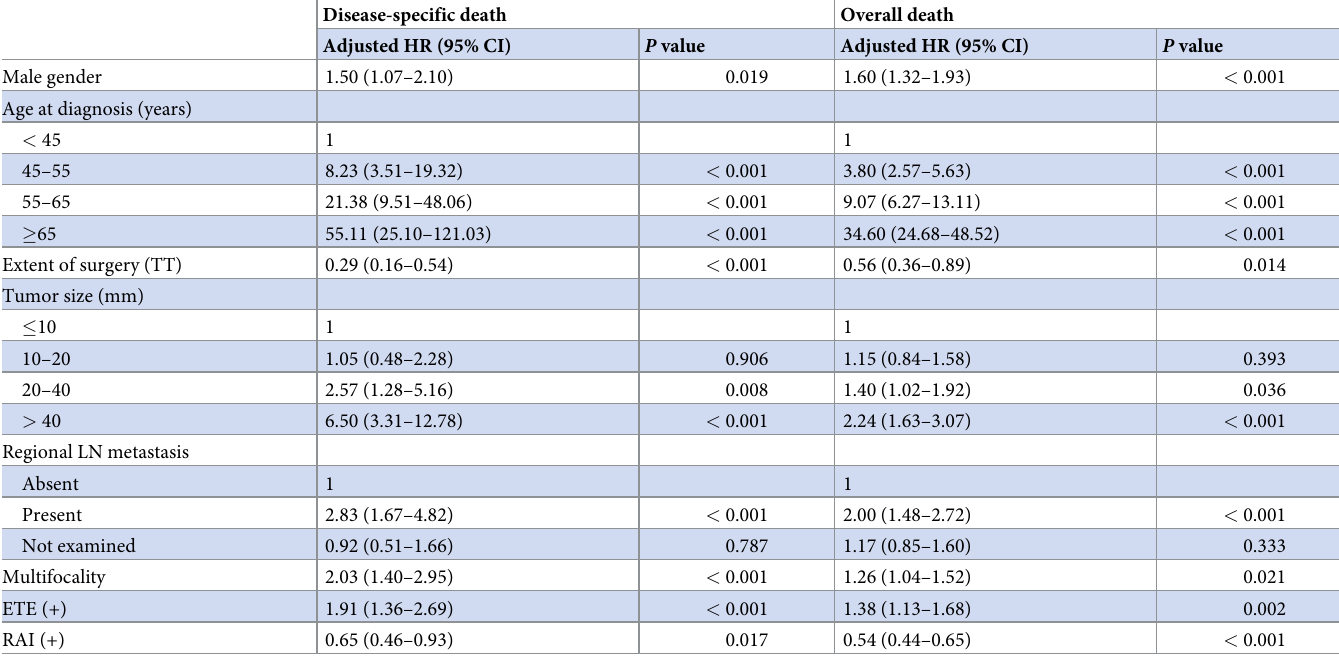
Table 2. Cox proportional hazards model for disease-specific death or overall death in intermediate risk PTC